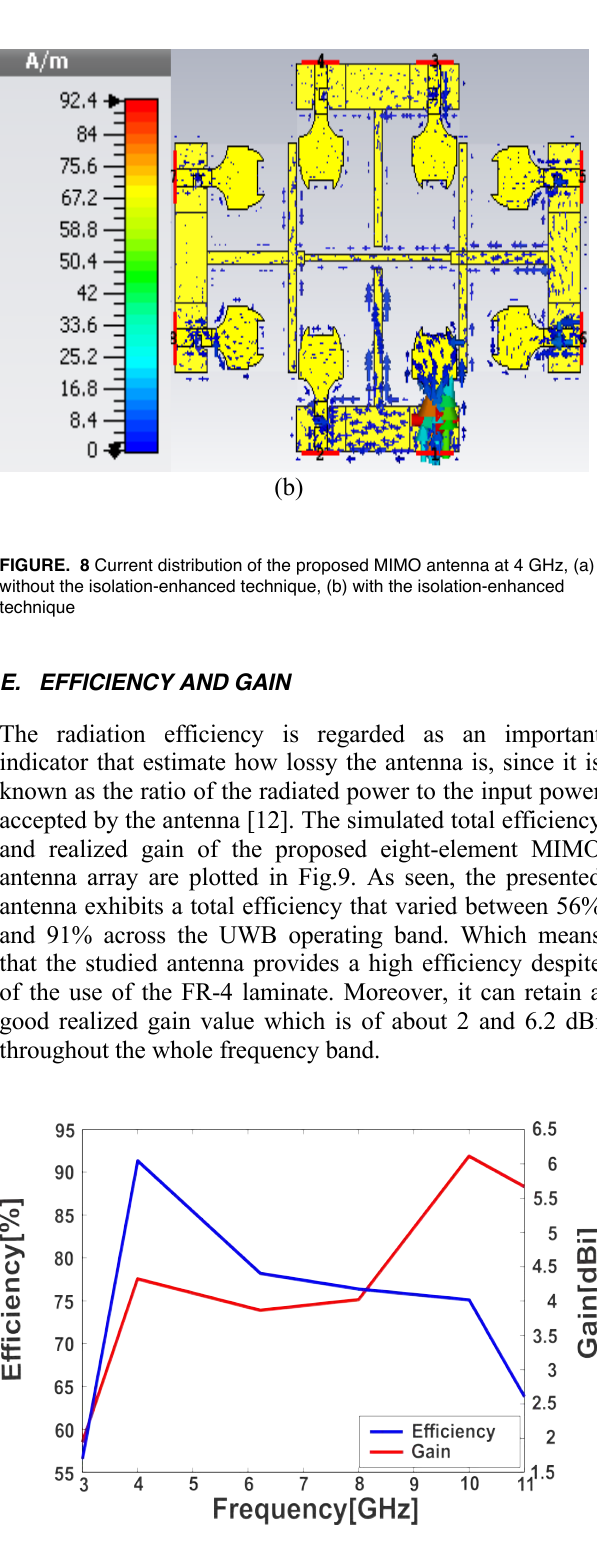
FIGURE. 9 Simulated gain and efficiency of the presented MIMO antenna